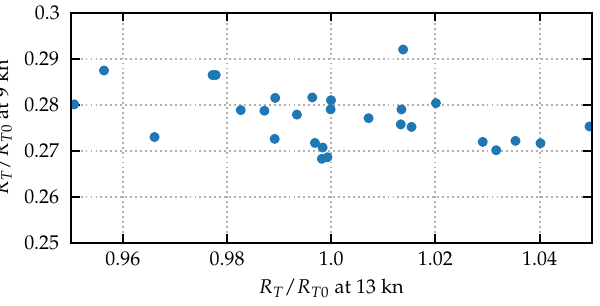
Figure 4. Non-dimensional resistance at design speed vs. non-dimensional resistance at lower speed.